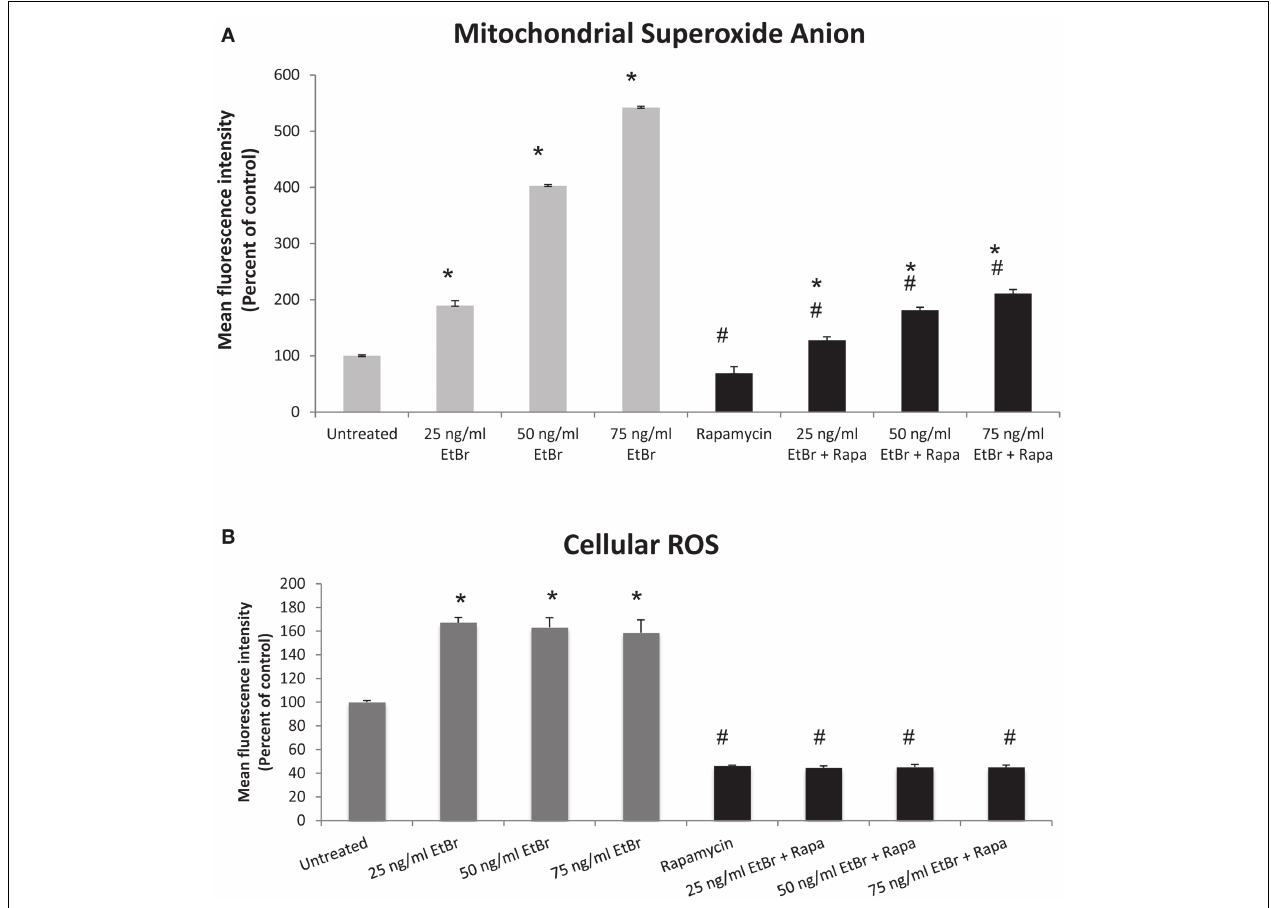
are presented.The concentration of ethidium bromide is indicated beneath each bar. Differences between cultures exposed to ethidium bromide and unexposed cultures, which are significant at P < 0.05 are indicated by an asterisk and differences between control and rapamycin treated cultures under identical conditions are indicated by a pound sign.The graph contains a representative experiment of a minimum of three independent replicates with similar results and